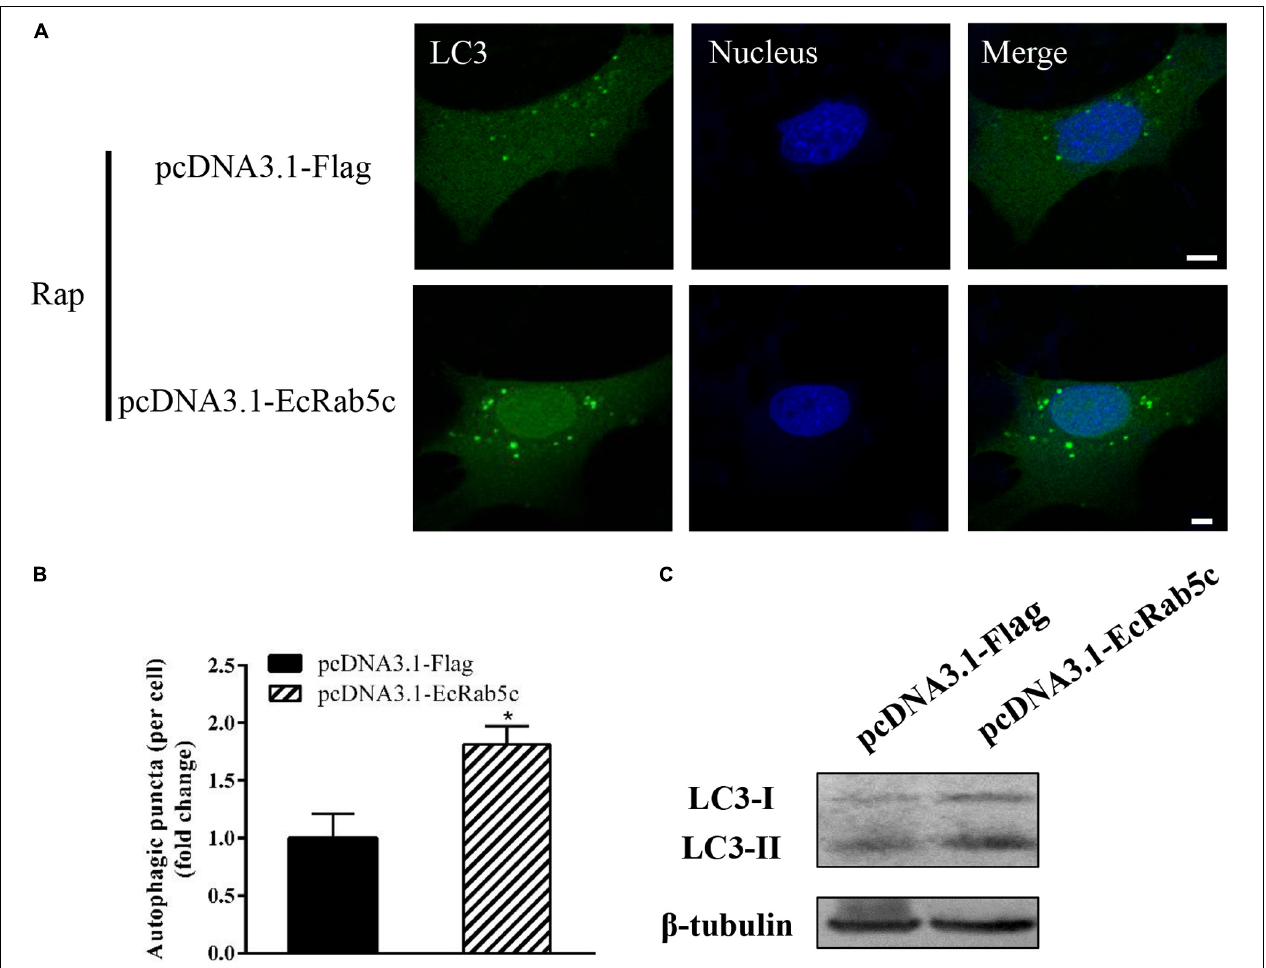
FIGURE 7 | Overexpression of EcRab5c promoted autophagy. (A) Overexpression of EcRab5c enhanced autophagosome formation. GS cells were transfected with pcDNA3.1-Flag/pEGFP-LC3 or pcDNA3.1-EcRab5c/pEGFP-LC3, respectively, and then incubated with 1 µ M Rap for 2 h. The nucleus was stained with Hoechst 33342. Scale bars are 5 µ m. (B) Quantification of LC3 puncta/per cell in (A) was expressed as mean ± SEM, n = ∼ 90 cells of 3 independent experiments. * p < 0.05. (C) Overexpression of EcRab5c increase the level of LC3-II by Western